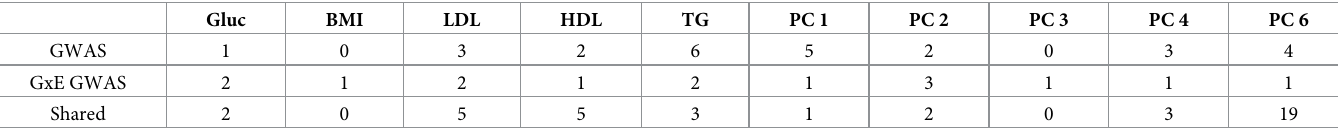
Table 1. Number of genome-wide significant loci for GWAS and GxE GWAS. Shared describes the number of loci that are significant in both the GWAS and GxE GWAS for the same trait ( r 2 < .2), while GWAS and GxE GWAS describe the loci unique to that association scan. No loci were found for CHD, insulin, or WHR. Both approaches found a single preT2D locus. We excluded NMR PC 5 because of GxE GWAS